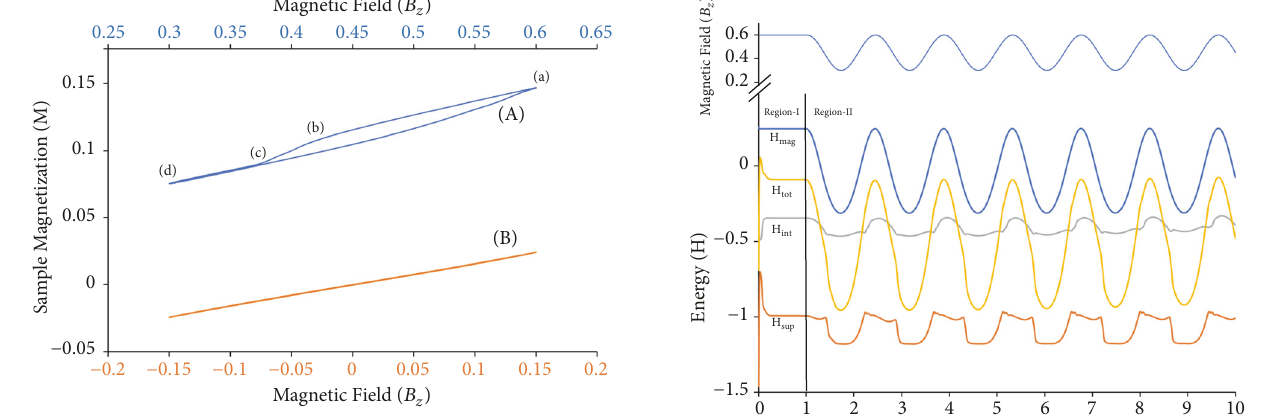
Figure 2:Magnetization( 𝑀 = ∇×𝐴 )vs. magneticfield ( 𝐵 𝑧 )plot for cubic sample of side 20𝜉 each, with parameters 𝜅 =4 and 𝜎 =1 under magneticfield oscillations of the type (A) B z =0.45 𝜅 + 0.15 𝜅 cos 𝜃 and (B) 𝐵 𝑧 = 0.15𝜅 cos 𝜃 .